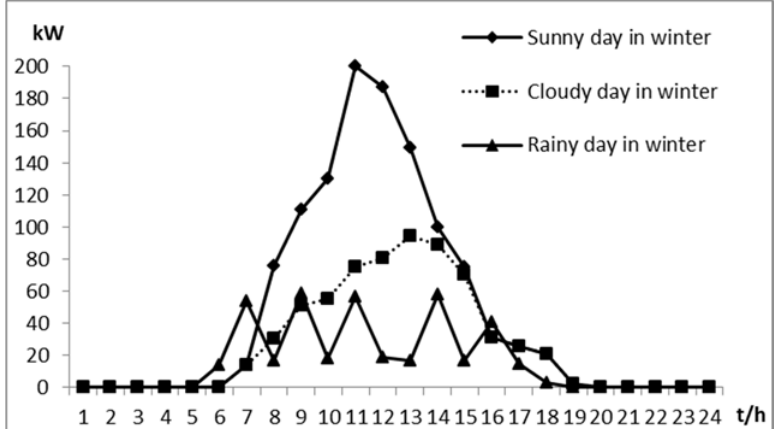
Figure 4. Photovoltaic output curves for three typical weather days.